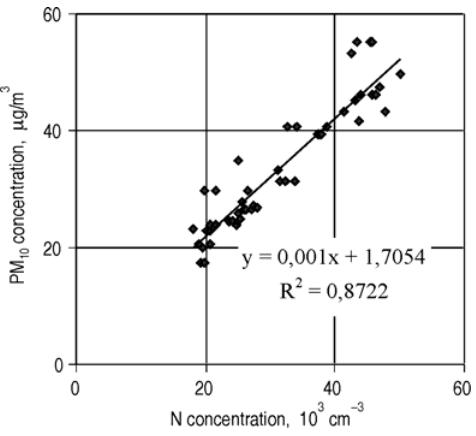
Fig 7 . Relationship between aerosol number (N) and PM 10